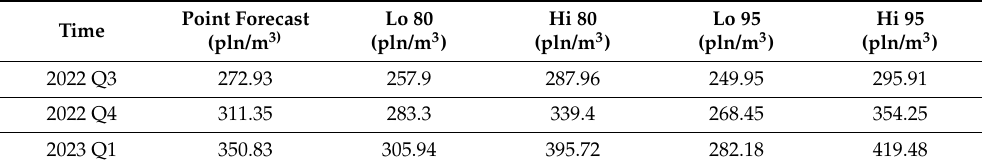
Figure 6. Prices for the S2AP assortment at quarterly intervals in years 2018–2022. Source: Own elaboration based on data obtained from the State Forests IT System (SILP).